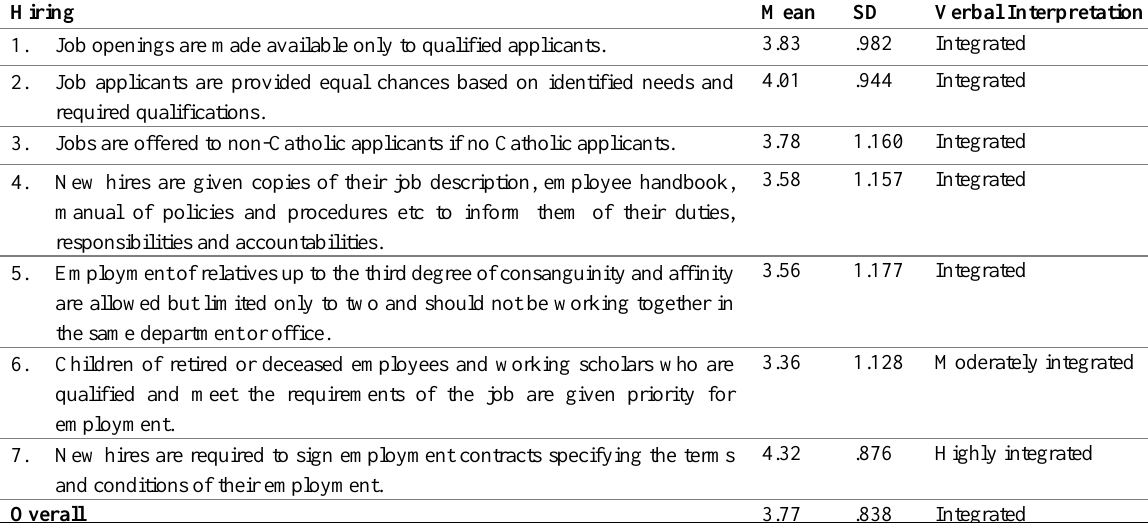
Table 4: Extent of Integration of Commitment to the Hiring as Perceived by Respondents Hiring Mean SD Verbal